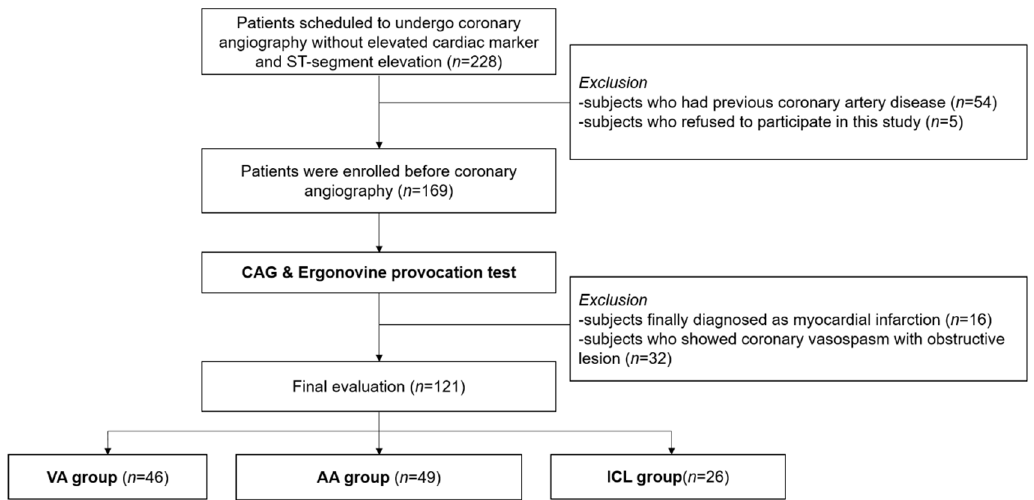
Figure 1. Patient enrolment flow. AA, atherothrombotic angina; CAG, coronary angiography; ICL, insignificant coronary lesion; VA, vasospastic angina.